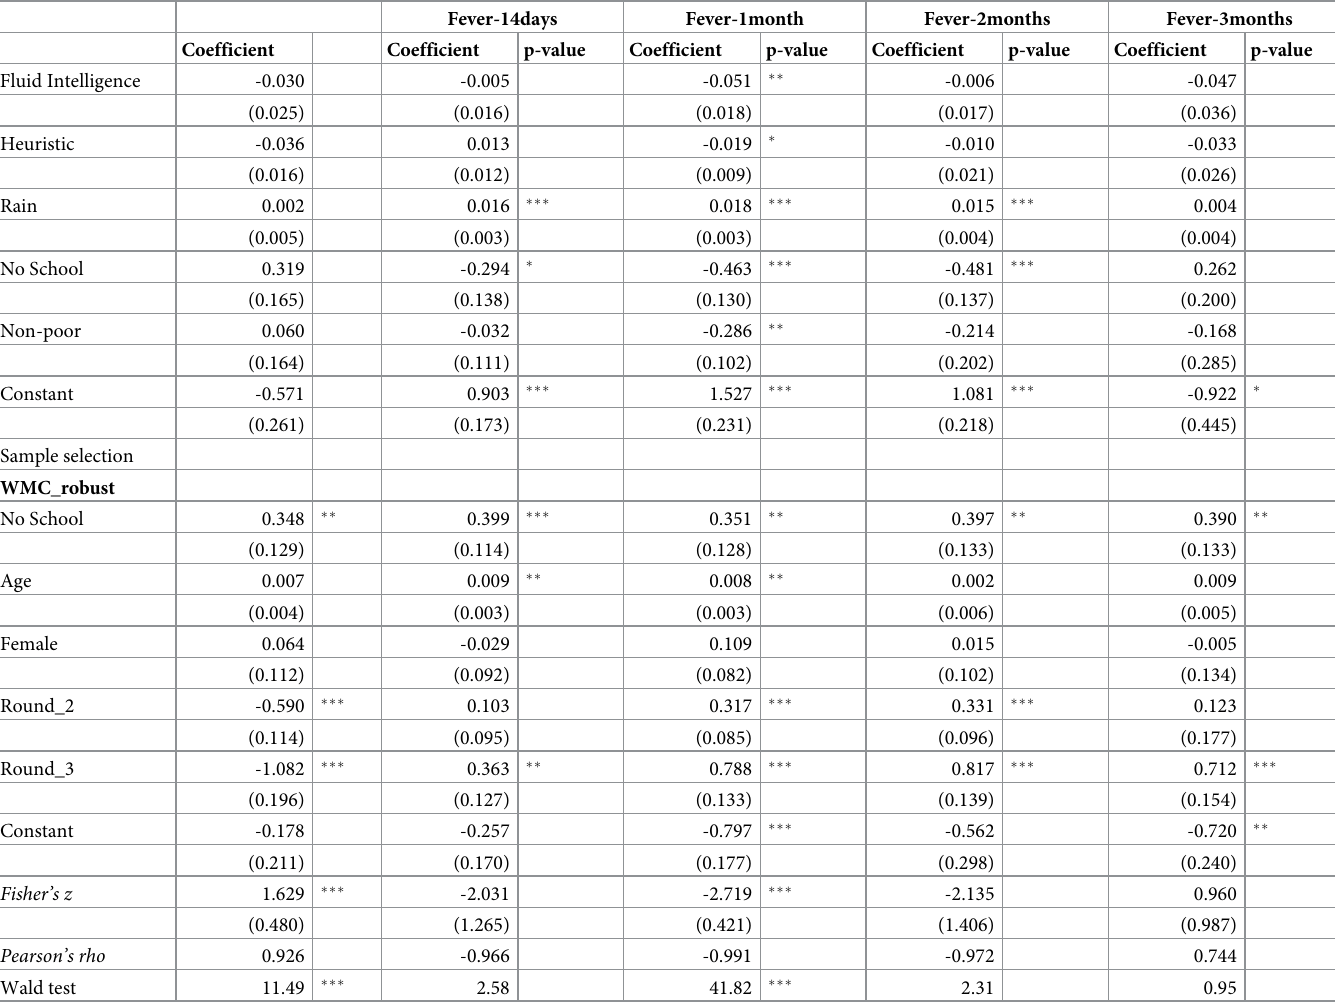
Table 5. Probit with sample selection (clustered by ID). –robustness